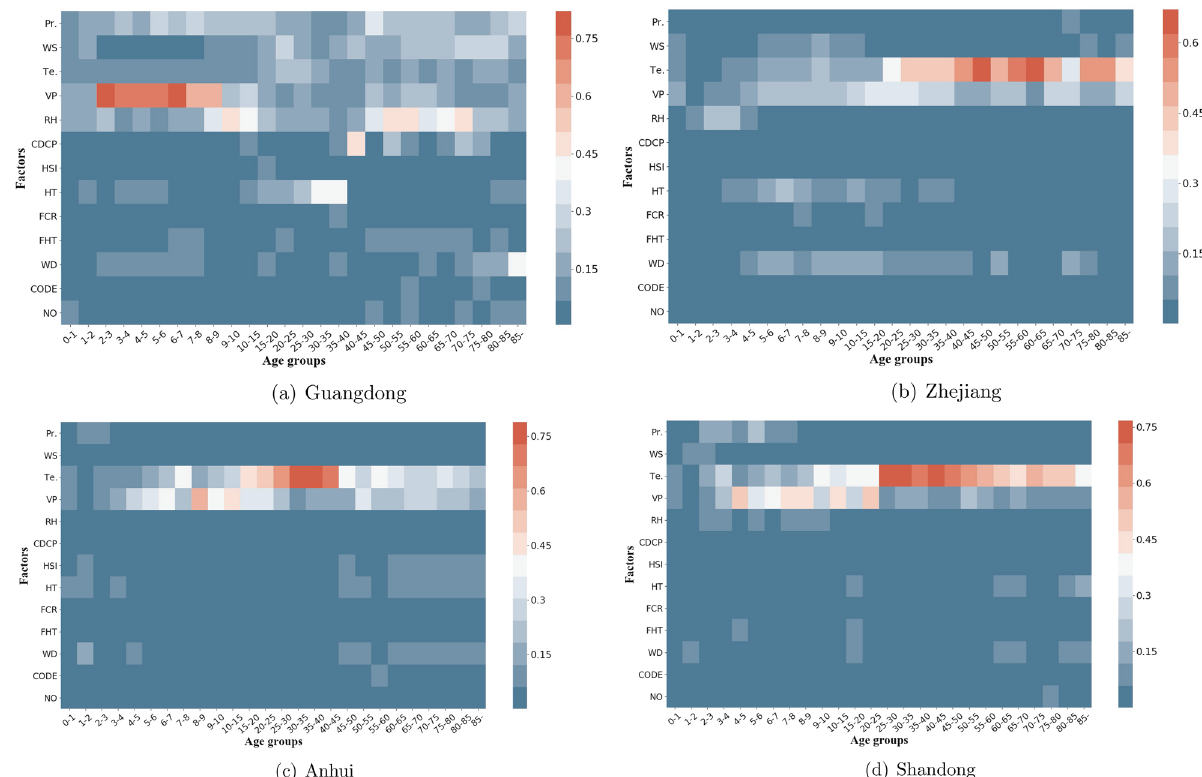
Figure 9. Heat maps of influence of potential factors on number of infected diarrhea cases of different age groups in the top four provinces with most infectious cases in mainland of China, from 2005 to 2017. (See Supplementary Tables 9, 10, 11, 12 in Supplementary material to obtain the detailed data). The heat map is created by package seaborn in Python 62 . Meteorological factors Pr.: precipitation, WT: wind speed, Te.: temperature, VP: vapor pressure, RH: relative humidity Social factors CDCP: the quantity of centers for disease control and prevention, HSI: the quantity of health supervision institute, HT: the quantity of health